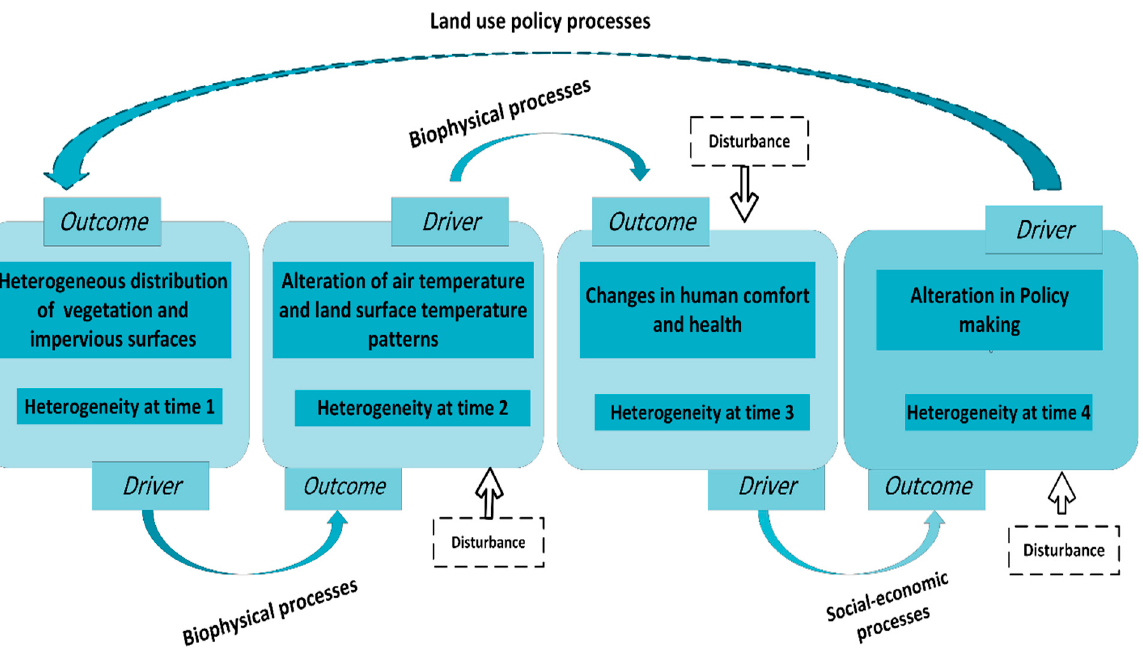
Figure 4. Model template: hypothetical driver–outcome spiral explaining the dynamics and heterogeneity of the UHI based on empirical evidence.